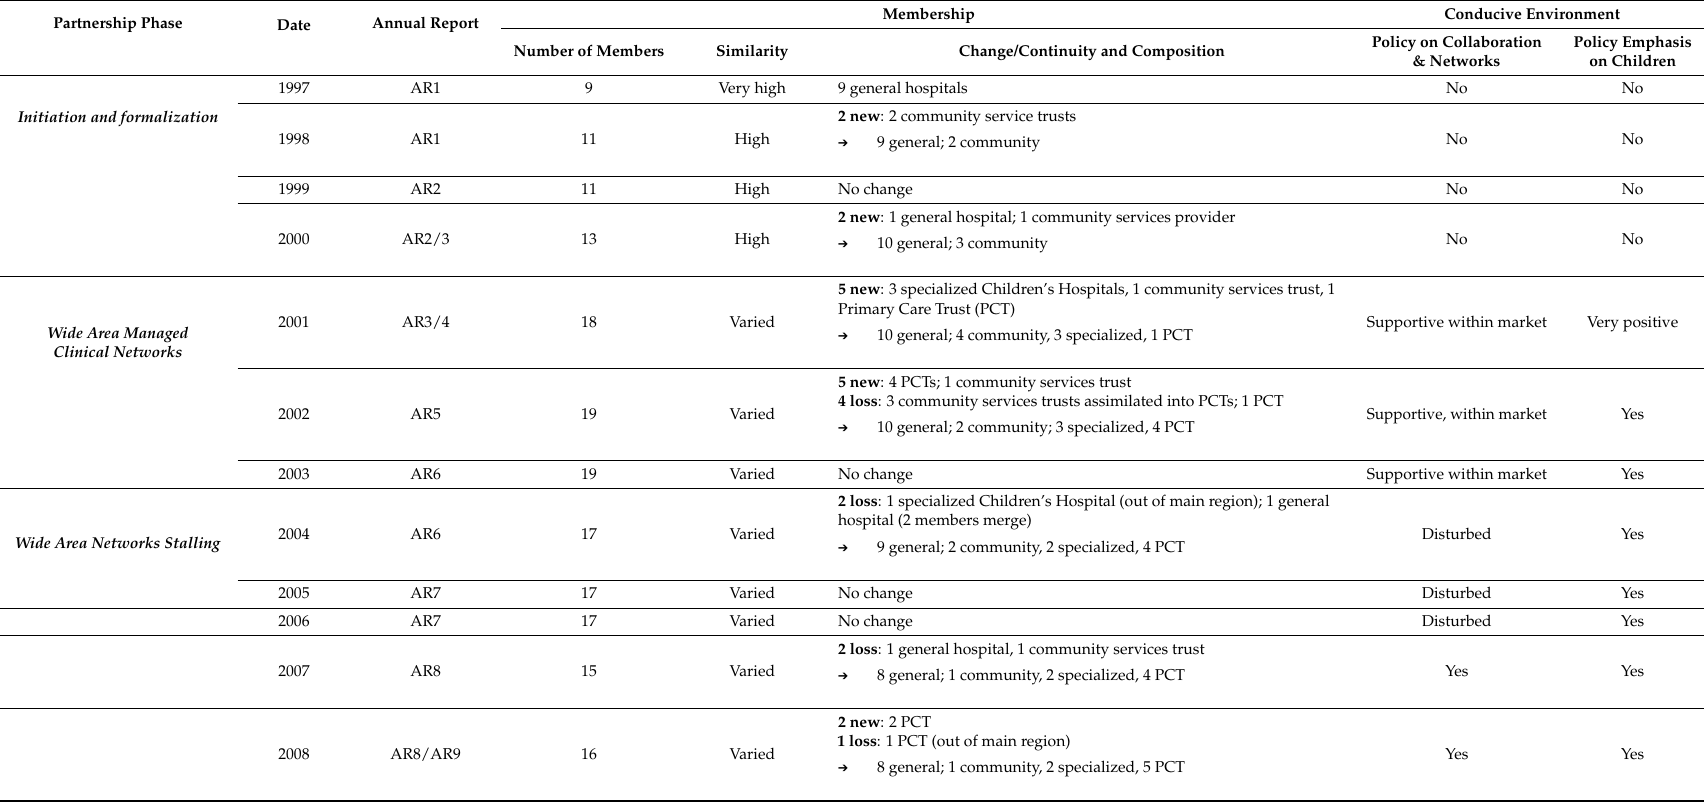
Table 1. Membership of the Partnership: Composition and changes